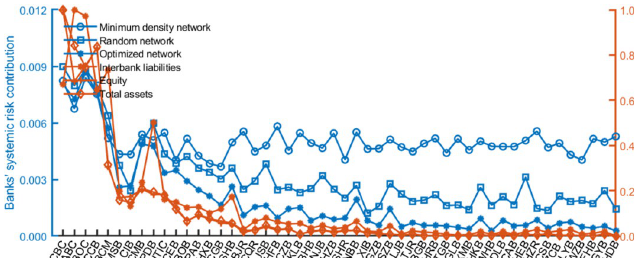
Fig 9. Banks’ systemic risk contribution before and after optimization. The risk contribution is averaged over ten years. The banks are in order by their total interbank assets. Figures below follow the same rules.